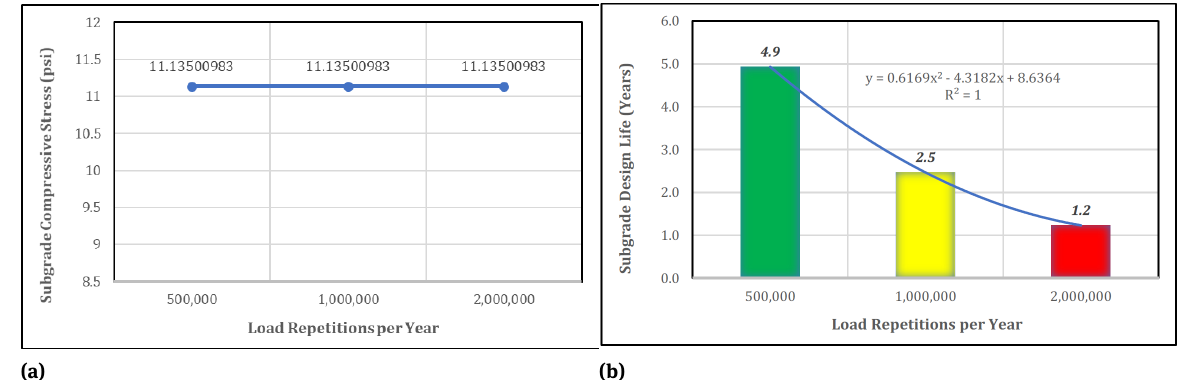
Figure 15: Influence of load repetitions on subgrade service life in granular rail track.